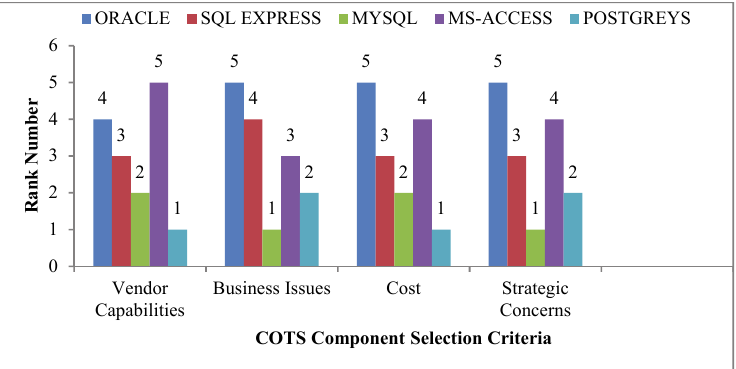
Fig. 5. Comparative rankings of COTS